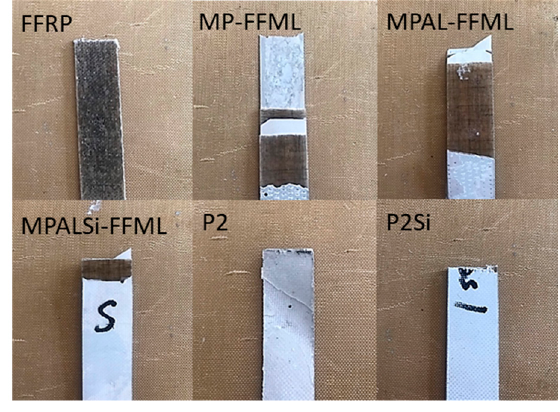
Figure 11. The damaged area of FFRP and five types of modified FFMLs following tensile tests.